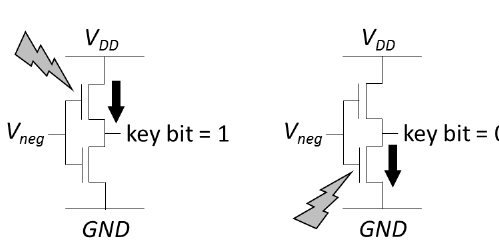
Figure 10: Second option for the key programming circuit.